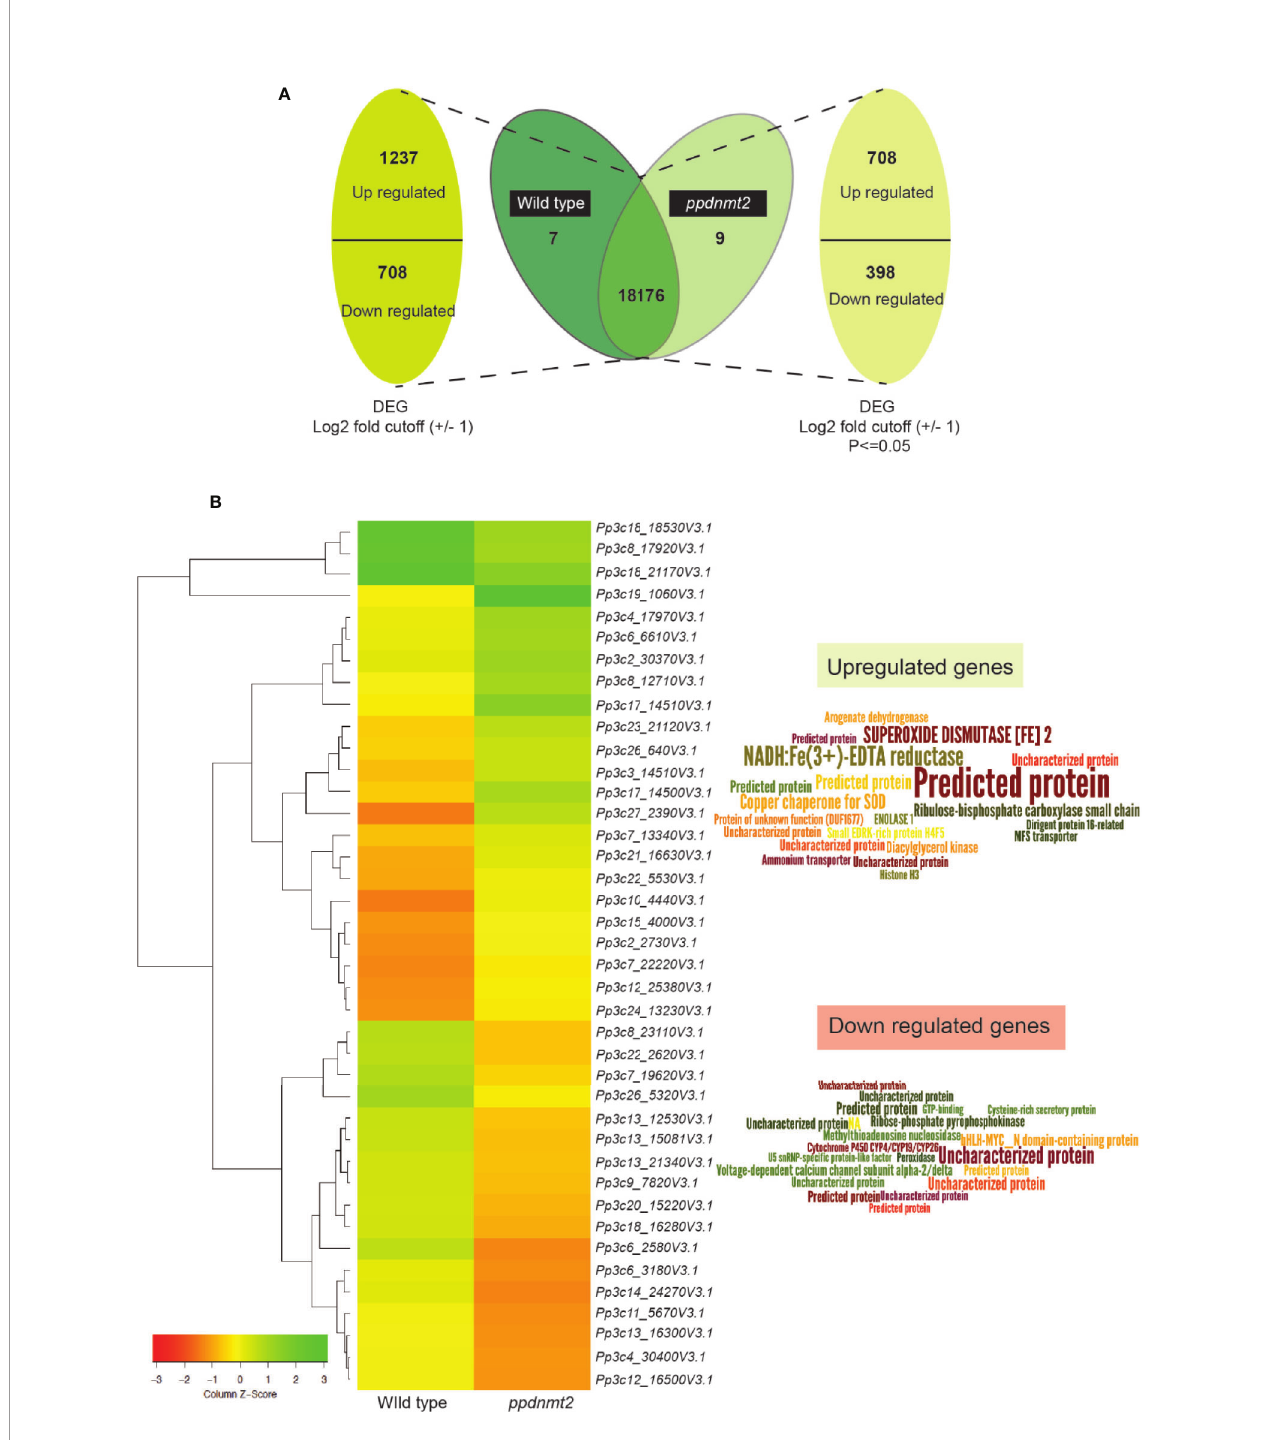
FIGURE 2 | (A) Representation of differentially expressed genes with numbers denoting upregulated/downregulated genes and those expressing in common and exclusively in wild type and ppdnmt2#8 , respectively. (B) Left: Hierarchical clustering analysis of top 20 up and downregulated genes displayed in the form of a heat map where green color shows upregulated and red depicts downregulated genes. Right: Word cloud representation of top 20 differentially expressed genes in ppdnmt2 where word size corresponds to Log 2 changes in transcript abundance (log 2 foldchange mutant/wild type ). Word clouds have been generated using Wordle.net.in using advanced